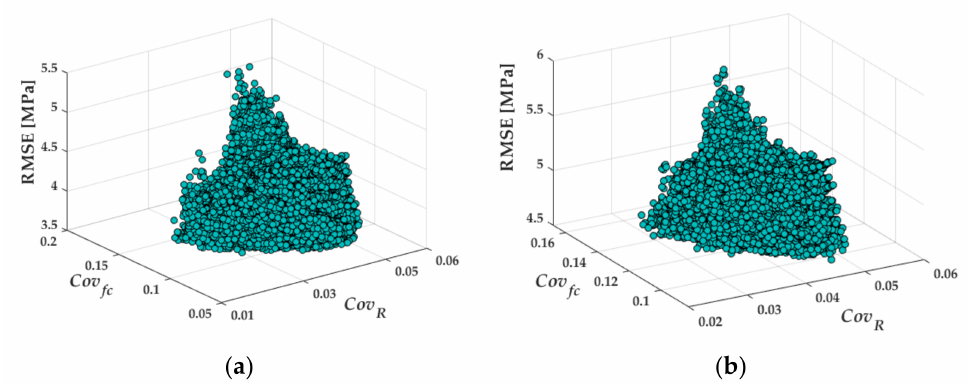
Figure 7. RMSE (Equation (10)) evaluated for the exponential conversion models vs. coefficient of variation of the in-situ concrete strength Cov fc and coefficient of variation of the rebound index Cov R : ( a ) m = 15; ( b ) m =